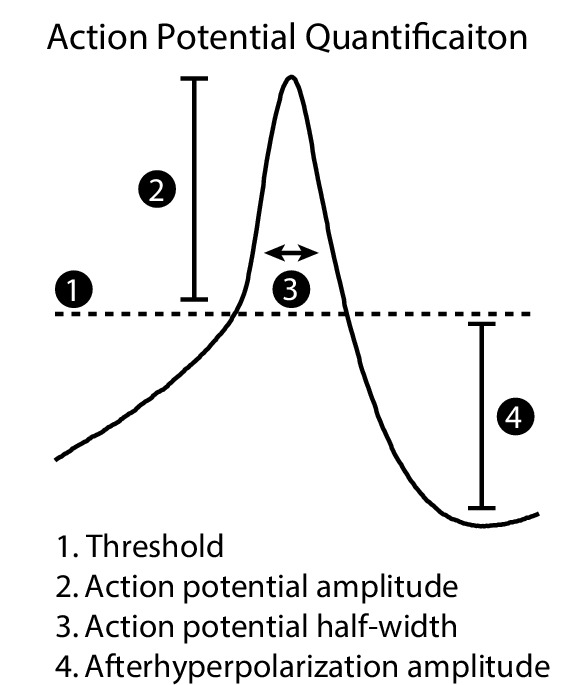
Action potential waveform measurements.Action potential threshold was the membrane potential at the first inflection point, calculated as 1.5 standard deviations away from the mean second derivative of the AP wave at baseline. Action potential amplitude (AP amp) was the difference in voltage between the threshold and the maximum potential. Action potential half-width (AP HW) was the AP width at half-max amplitude. After-hyperpolarization amplitude (AHP) was the difference in voltage between threshold and the minimum potential after the peak. AP amp, AP HW, and AHP measurements were averaged from all action potentials elicited from a standard current step protocol for each cell.